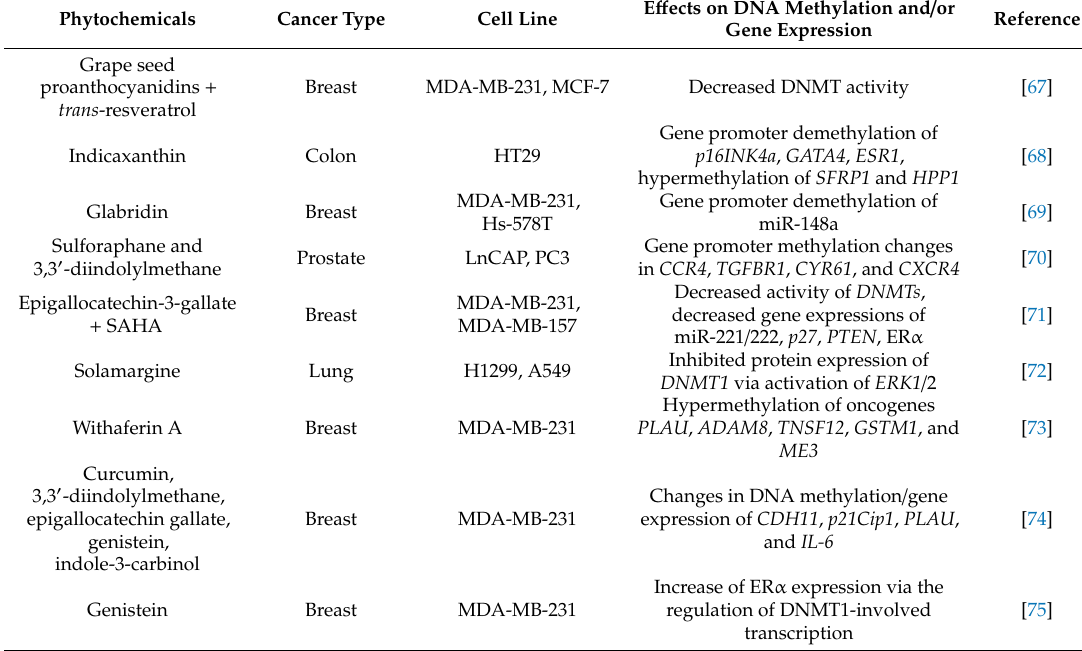
Table 1. DNA methylation patterns in cancer cell lines after treatment with plant natural compounds. SAHA: Suberoylanilide hydroxamic